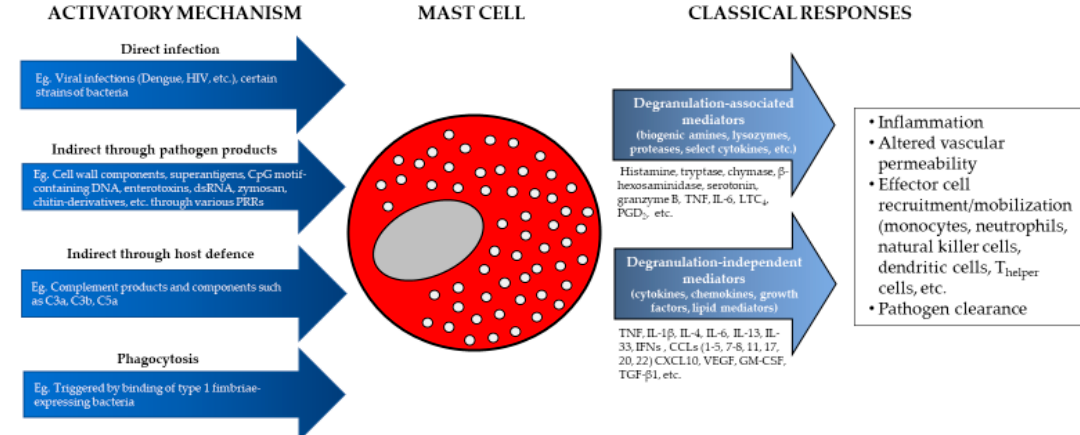
Figure 2. Mast cells can recognize and respond to pathogens either directly through pathogen infection, or indirectly through an array of pathogen products, host defense mechanisms, or phagocytosis. Activation results in the secretion of classical mast cell mediators that can be categorized as degranulation-dependent or degranulation-independent. These mediators contribute to the inflammation and changes to the site of pathogen infections, recruitment of other immune cell types, and regulation of the immune response to pathogens.